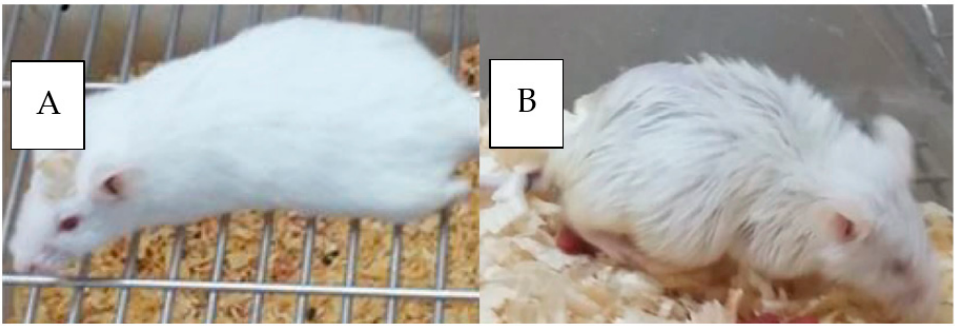
Figure 15. ( A ) Healthy mouse ( B ) Cancerous mouse.